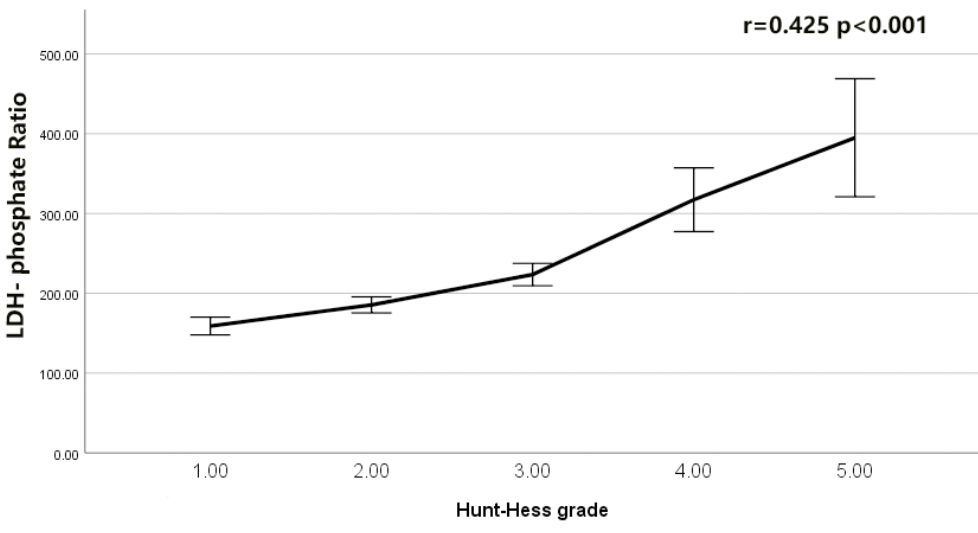
Figure 2. Correlation of LDH − phosphate Ratio with Hunt − Hess grade after intracranial aneurysm rupture.